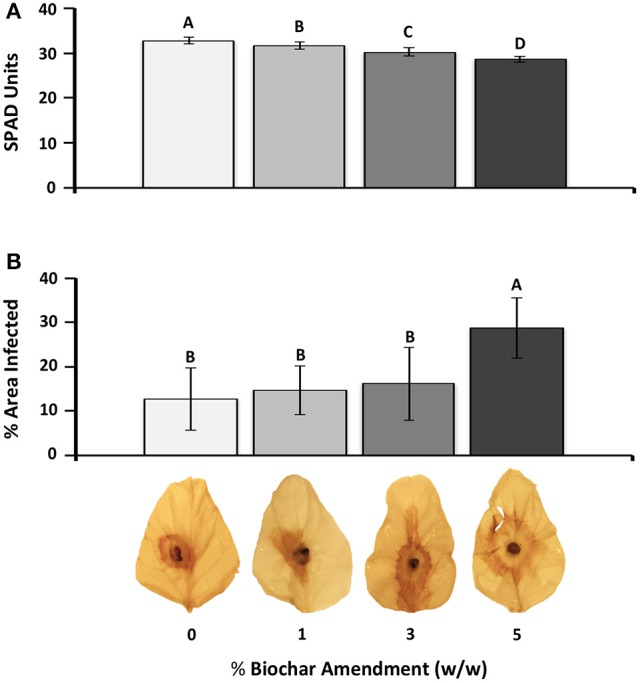
Effect of biochar amendment rates on soybean chlorophyll content and susceptibility to RFB disease. (A) Chlorophyll content in response to biochar amendment. Chlorophyll readings were taken on the two fully expanded unifoliate leaves of each plant (n = 12) and are represented as SPAD units. (B) Average leaf necrosis on detached leaves across different biochar amendment rates. Percent leaf area infected based on the area of necrosis as calculated using Image J software (n = 5). Letters represent significant differences based on Student's t-test (P < 0.05). Bars represent 95% confidence intervals.